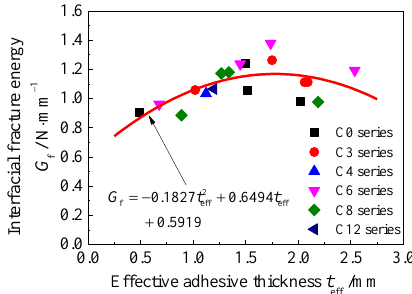
G versus the effective adhesive thickness f f versus the effective adhesive thickness t eff